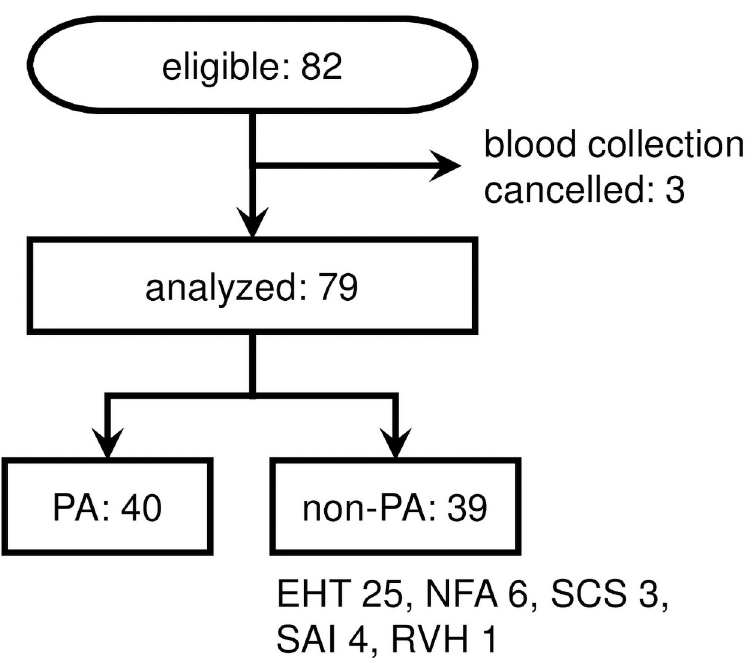
Fig 1. Study flow chart. PA: primary aldosteronism. EHT: essential hypertsnsion. NFA: non-functioning adrenal tumor without EHT. SCS: subclinical Cushing’s syndrome. SAI: secondary adrenal insufficiency. RVH: renovascular